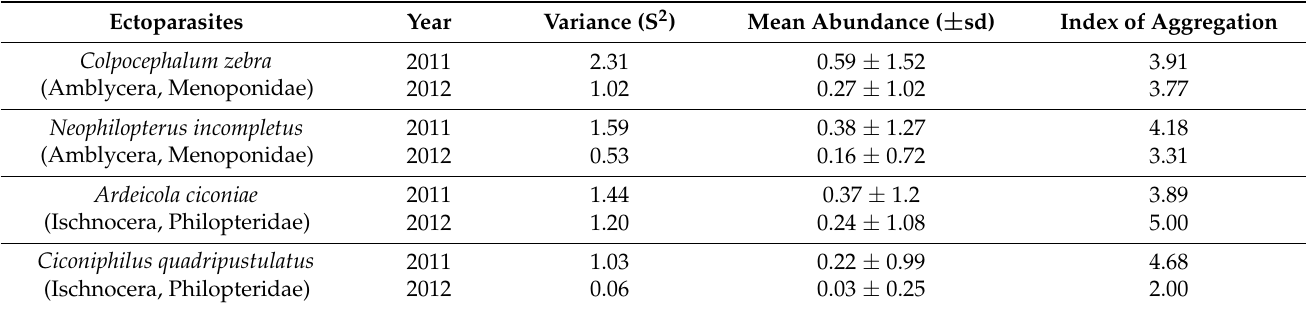
Table 2. The index of dispersion for feather lice at Dréan (2011 and 2012).